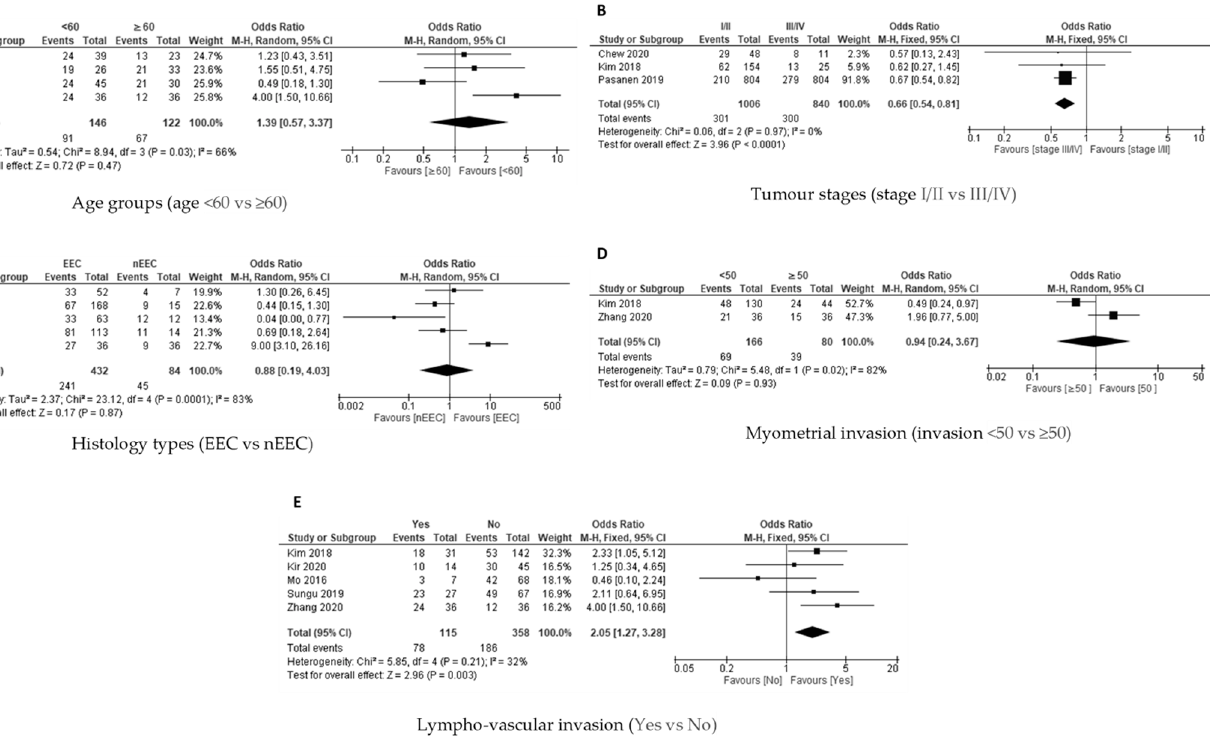
Figure 5. The PD-L1 positive expression among endometrial cancer cases in immune cells (ICs) [19,24,26–28,31,32]. Forest plot of ( A ) age group, ( B ) tumour stages, ( C ) histological types, ( D ) myometrial invasion, ( E ) lympho-vascular invasion.